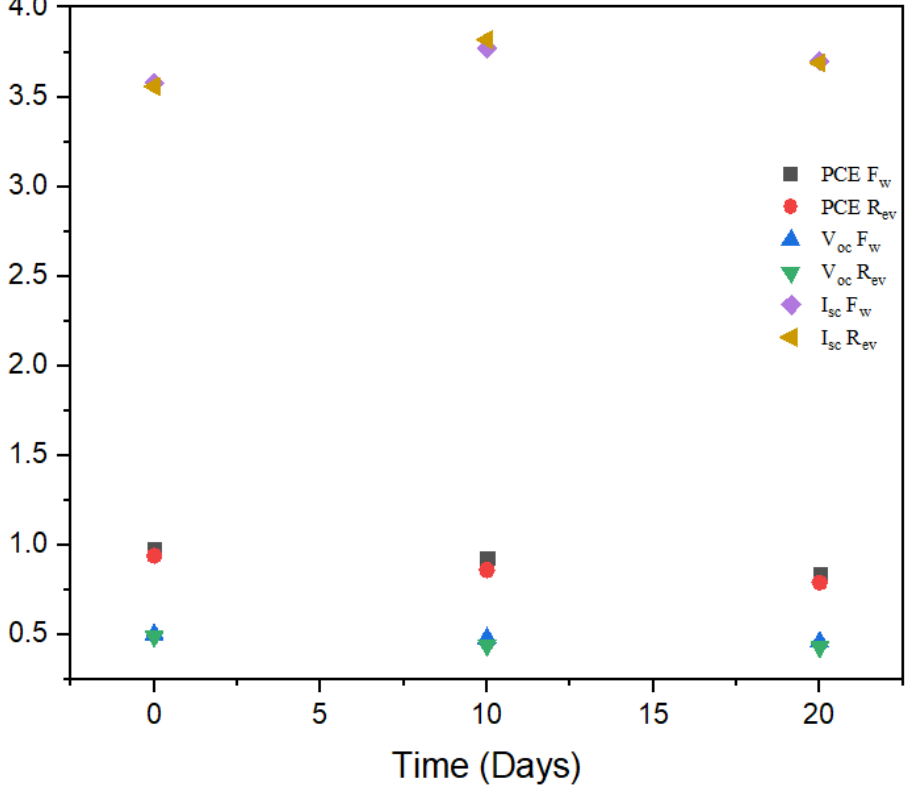
Figure 9. I sc , V oc , FF and PCE of perovskite solar cell stored for 20 days.